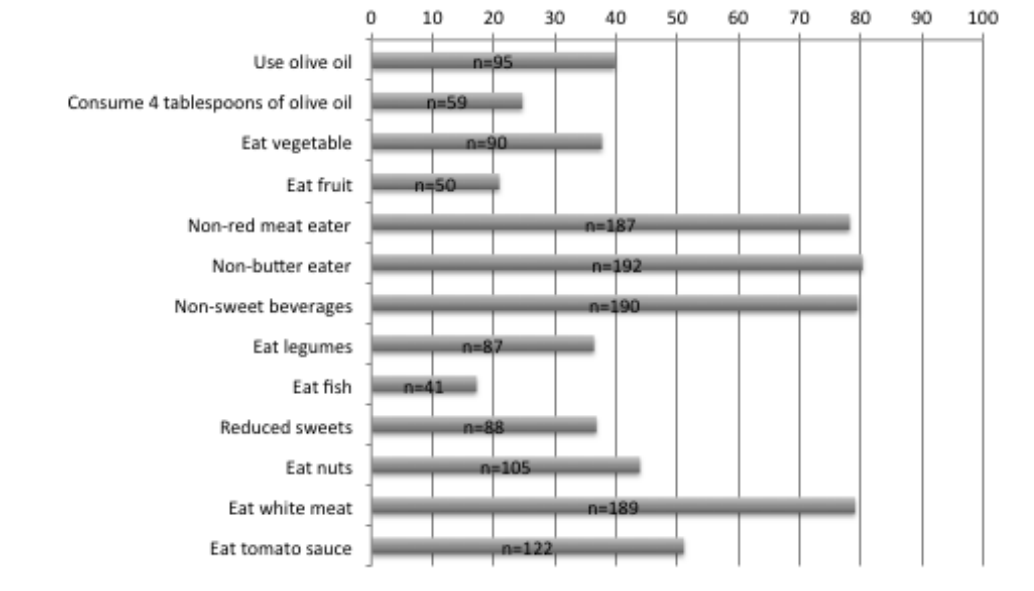
Figure 2. The number and percentage of the responses to Mediterranean diet